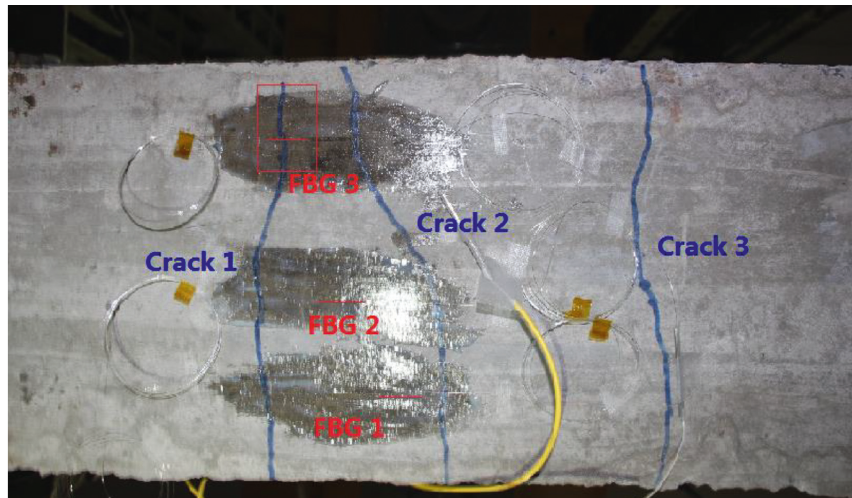
Figure 13: Cracking of the beam